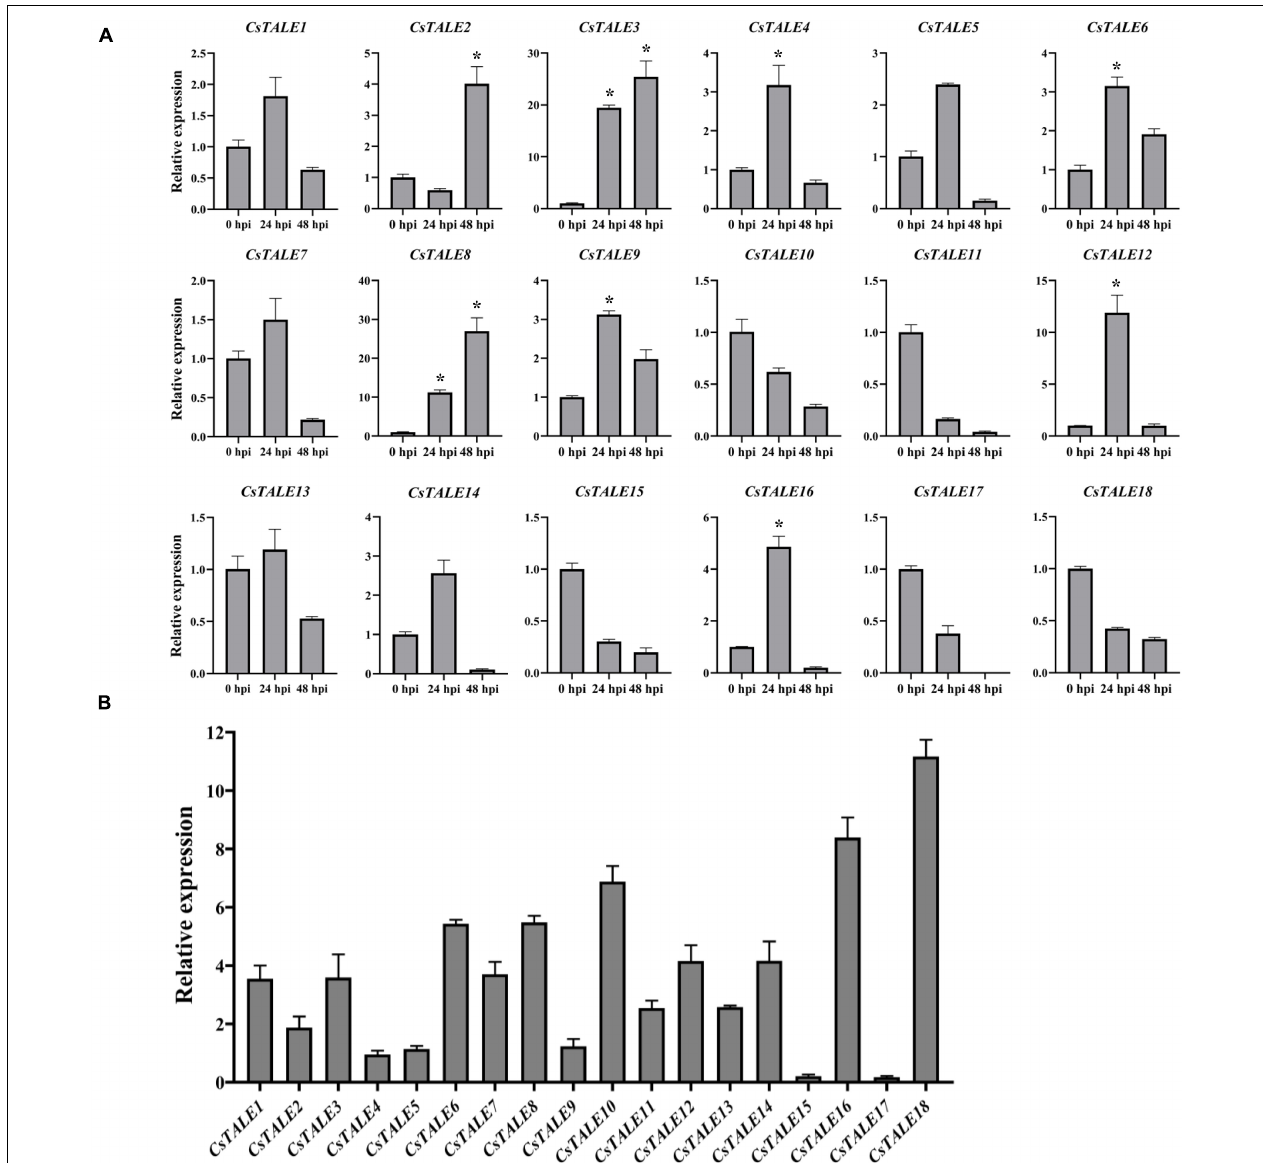
FIGURE 5 | Expression levels of CsTALE genes under different biotic stress. (A) The Y -axis represent the relative expression level of CsTALE genes and the X -axis indicate different time points post Diaporthe citri inoculation. (B) The X -axis represented the different CsTALE genes and the Y -axis represent the relative expression level after Candidatus Liberibacter asiaticus-infected. The gene transcription levels in C Las-free plants were normalized as 1. The standard errors are plotted using vertical lines. * Represents significant difference ( p < 0.05). The experiments in all panels were repeated three times with similar